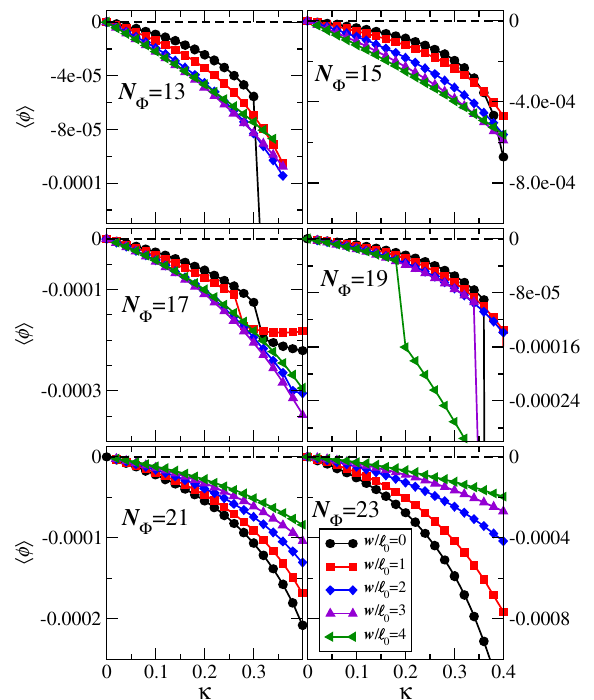
FIG. 11. The expectation value of the particle-hole- antisymmetric order parameter for the ground state of Eq. (2) in the spherical geometry at the particle-hole-symmetric shift N ¼ 2 N − 1 for N ¼ 13 , 15, 17, 19, 21, and 23 as a function Φ e Φ of κ for w= l 0 ¼ 0 – 4 . Note that the y axis is not the same scale for each system size.